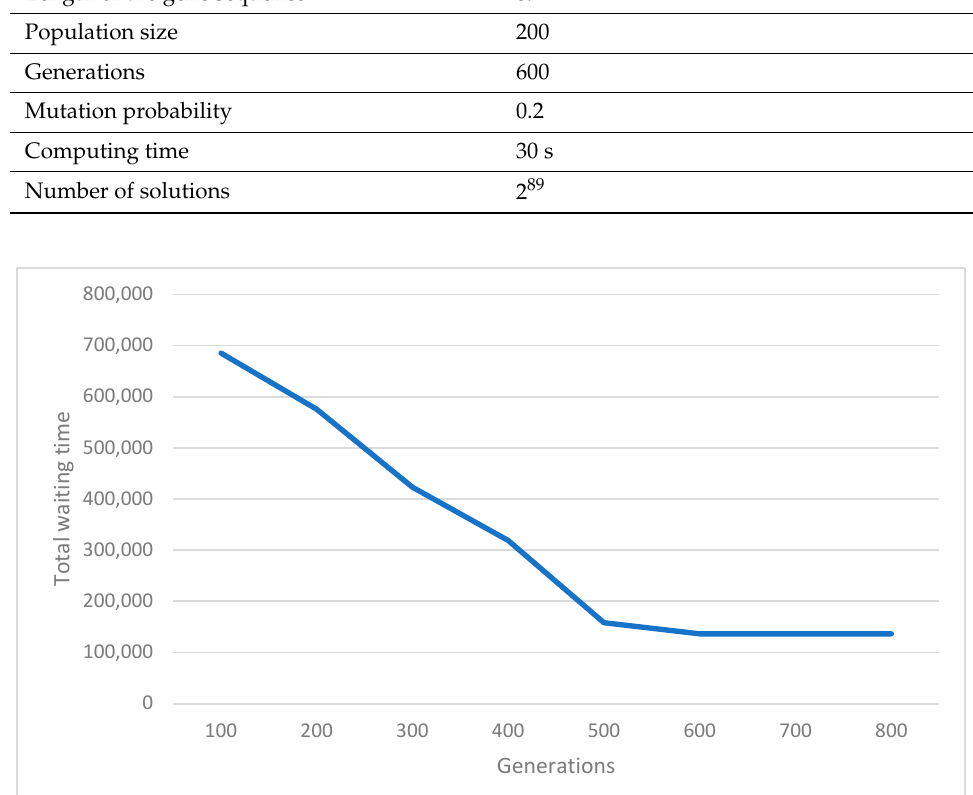
Table 5. The parameters of the GA_RPOM for this case study.